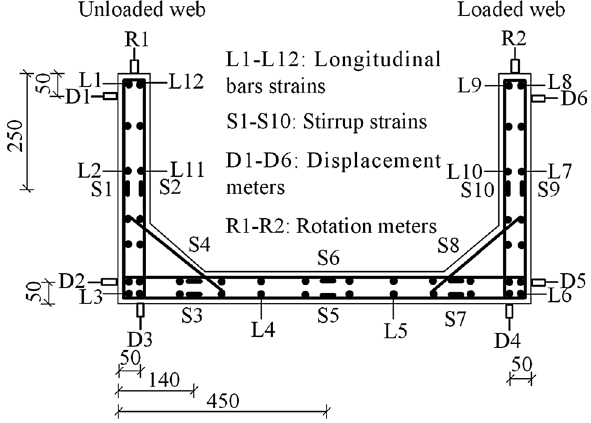
Fig. 4 Arrangement of measuring points around the selected sections (unit: